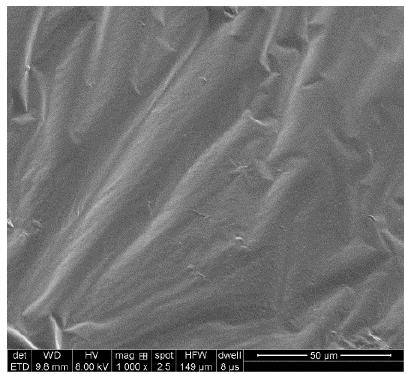
Figure 2. SEM image of the base asphalt.